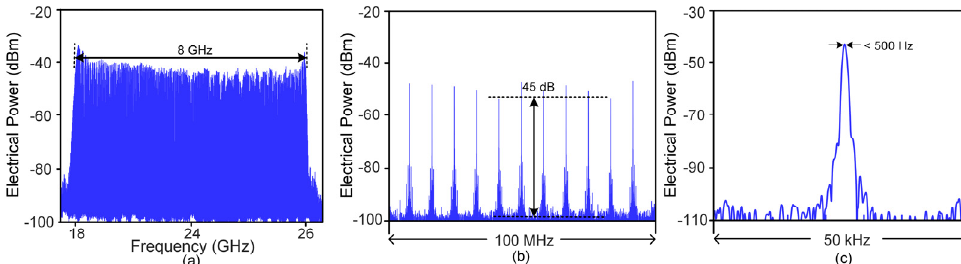
Figure 11. Electrical spectra of the generated dense MFC signals [56]. ( a ) Span: 9 GHz, RBW: 10 kHz; ( b ) Span: 100 MHz, RBW: 6.25 kHz; ( c ) Span: 50 kHz, RBW: 500 Hz.